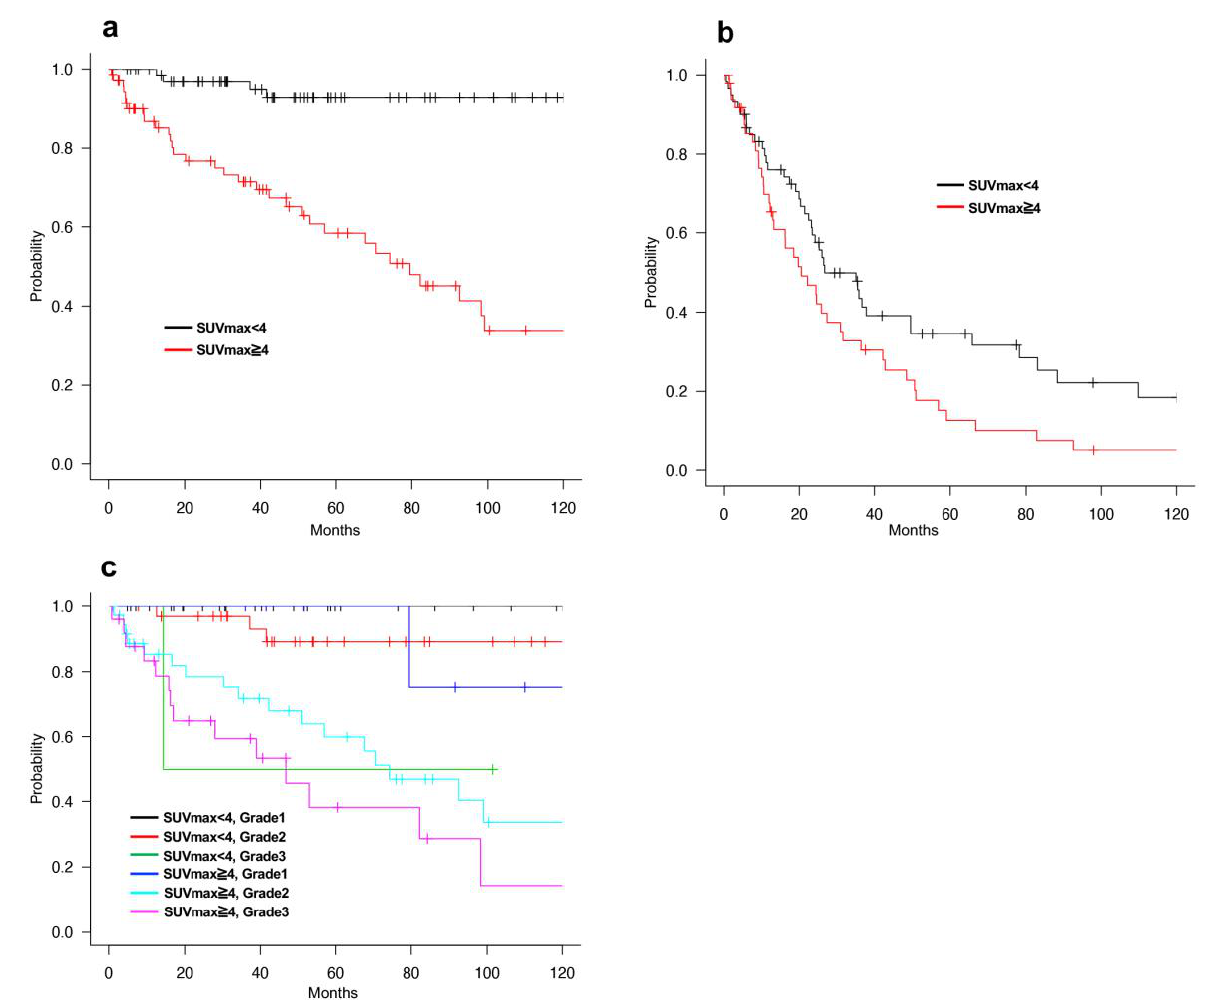
Figure 2. ( a ) OS of all RPS patients with SUVmax low (<4) or SUVmax high ( ≥ 4). ( b ) DFS of all RPS patients with SUVmax low (<4) or SUVmax high ( ≥ 4). ( c ) OS of RPS patients with SUVmax low and SUVmax high group by stratification with tumor grade.